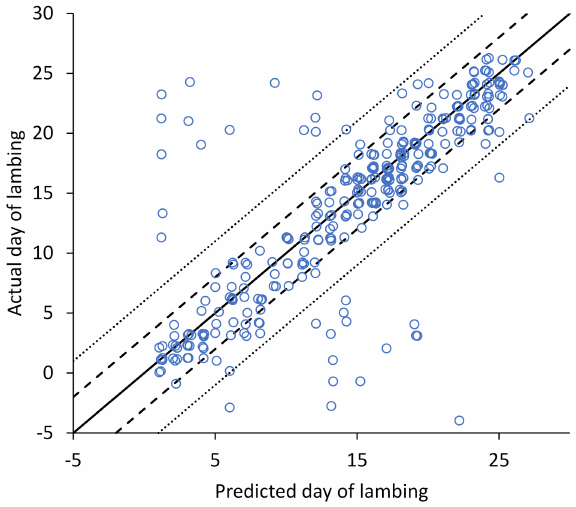
Figure 3. The predicted day of lambing based on 150 days after the maximum daily interactions ratio compared to the actual day of lambing. A small random jitter of less than ± 0.3 was added so ewes with the same combination are slightly offset. Day 0 of lambing is 150 days after rams went in with the ewes. The solid line represents when the predicted day of lambing is the actual day of lambing. The dashed and dotted lines are ± 3 and ± 6 days respectively.